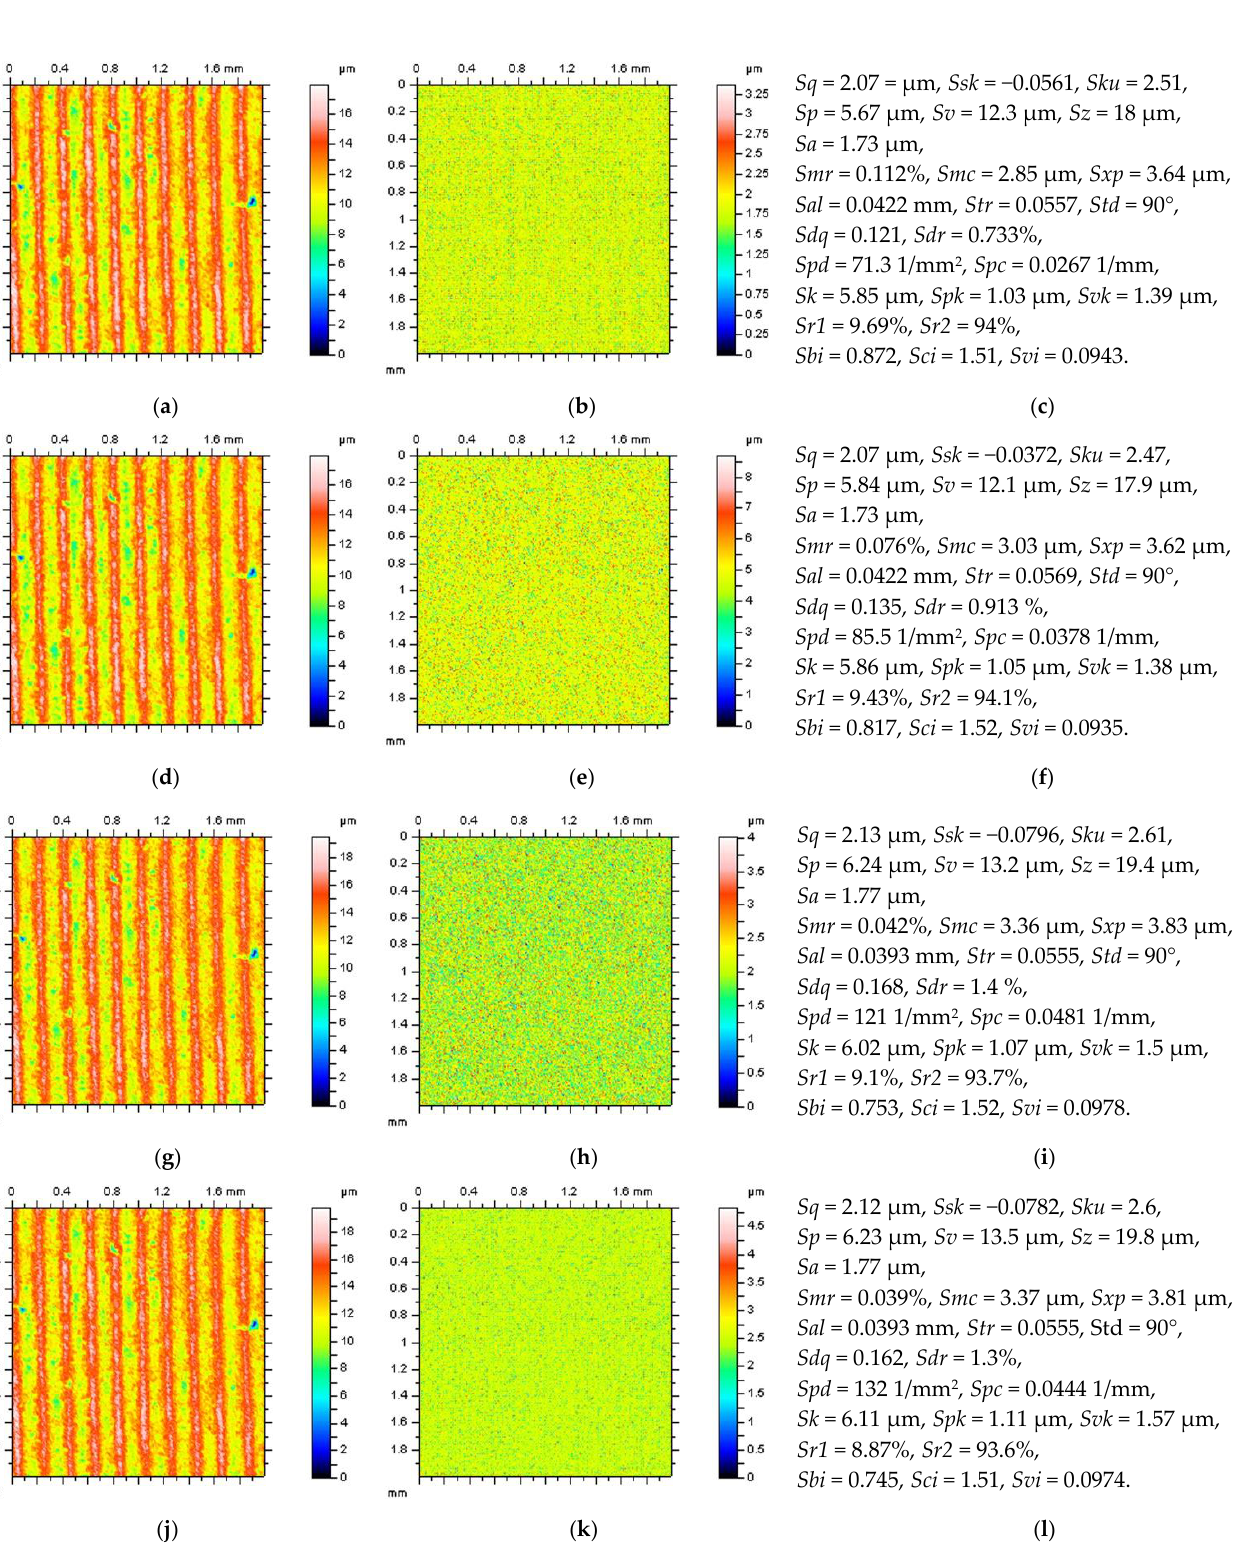
Figure 2. The turned surface after noise removal: contour map plots of the data with removed noise ( a , d , g , j ), contour maps plots of NSs ( b , e , h , k ), and the ISO 25178 topography parameters of the surface after noise reduction ( c , f , i , l ), respectively, received after application of GF ( a – c ), RGF ( d – f ), SF ( g – i ), and FFTF ( j – l ). Cut-off = 0.015 mm.